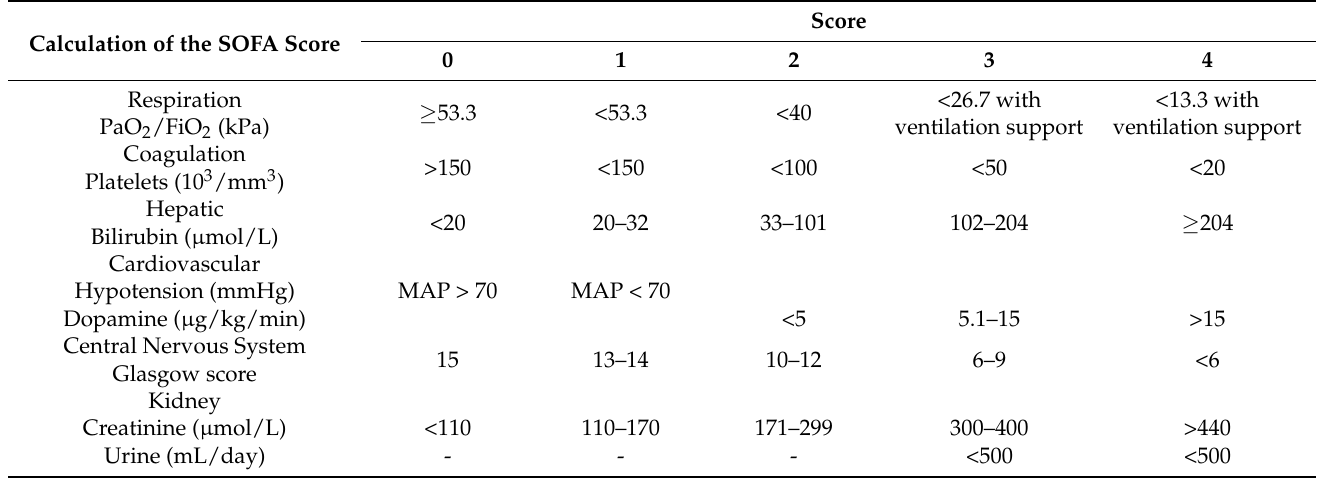
Table 1. Assessment of MODS (multiple organ dysfunction syndrome) by the SOFA (sequential organ failure assessment) score adapted from Teggert et al., 2020